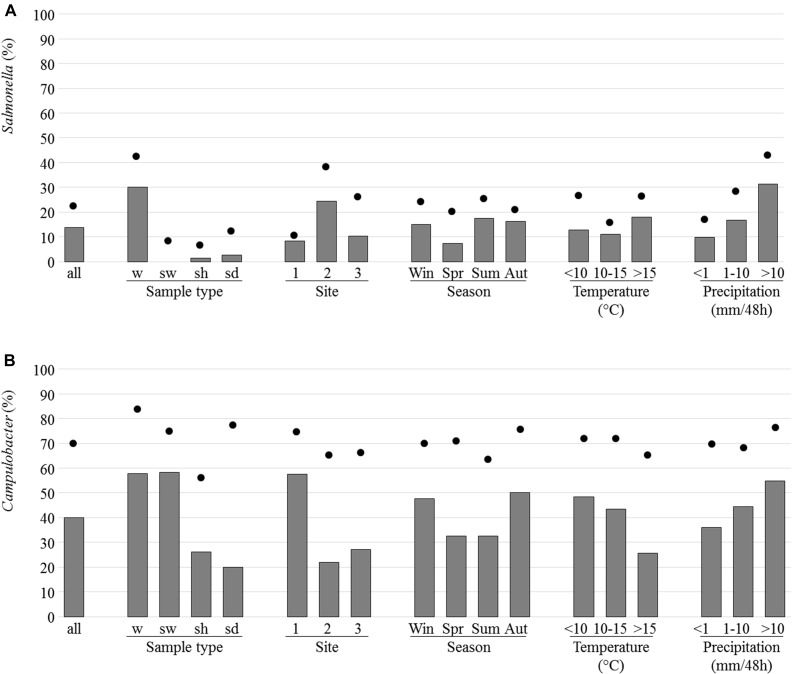
Prevalence and isolation of Salmonella
(A) and Campylobacter
(B). The prevalence which corresponds to the presence of the invA or ttrBCA genes in selective enrichments for Salmonella or 16S RNA genes in Bolton broth for Campylobacter (dots) and the percentage of samples for which at least one strain was isolated (bars) are indicated as regard to sample type [water from river and brackish water (w), seawater (sw), shellfish (sh), and sediment (sd), site, season, temperature, and precipitation].